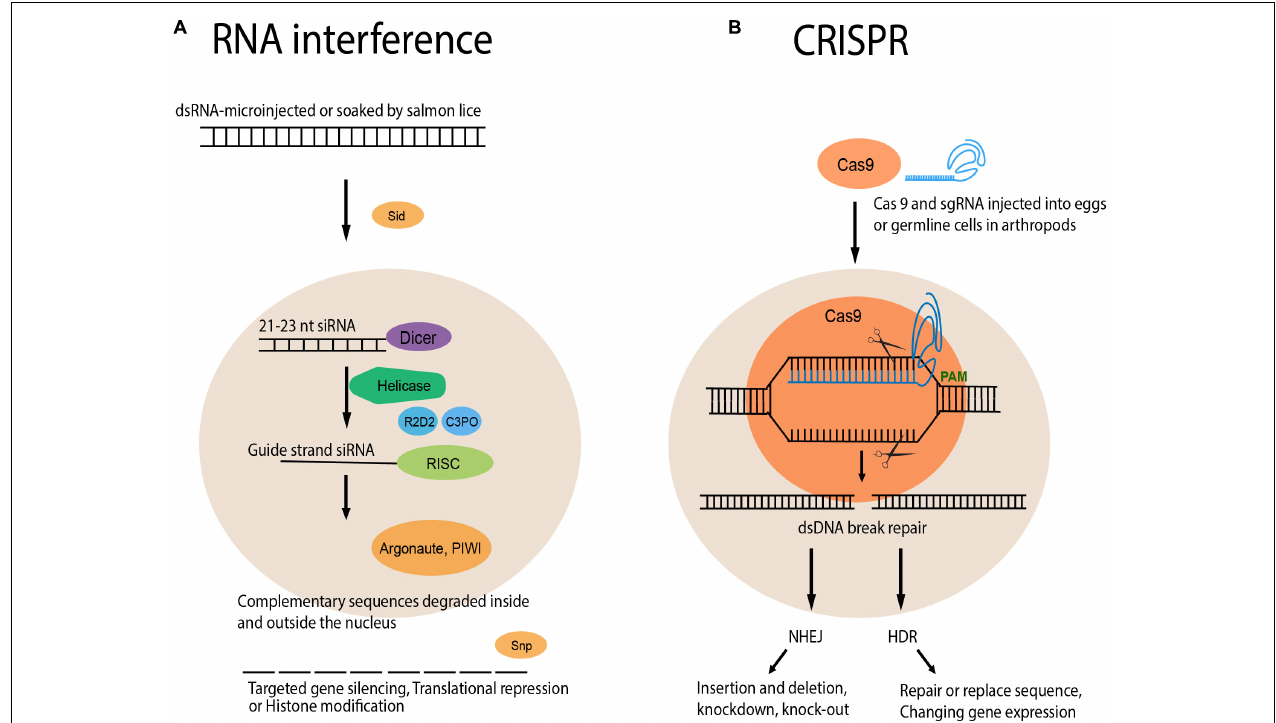
FIGURE 2 | Schematic representation of RNA interference and CRISPR/Cas9 technology. Two methods to target the activity of specific genes in the organism that are valuable for the functional study of genes and genetic elements. (A) RNA interference is a reverse genetics approach to study genes by knocking them down and then evaluating the effects. RNAi can be achieved in salmon lice by microinjecting dsRNA into pre-adult/adult lice or by immersing nauplii in dsRNA solution. dsRNA is incorporated in the cell with Sid, cleaved by Dicer into 21 nt small interfering RNA (siRNA), loaded into RNA-induced silencing complex (RISC) by R2D2 and C3PO. Argonaute and PIWI endonucleases degrade complementary RNA inside the nucleus, whereas Snp exonucleases degrades RNA outside. (B) CRISPR/Cas9 has the precision to target and knock out a single gene or genes in a gene family. Although the CRISPR/Cas9 is yet available for salmon lice, Cas9 and single guide RNA (sgRNA) can be injected into the eggs or germline cells similar to other arthropods. sgRNA forms a complex with Cas9 endonuclease, producing a dsDNA break. The dsDNA break is repaired by Non-homologous end joining (NHEJ) or homology directed repair (HDR). As a consequence, genes would be knocked out, knocked down, upregulated, or silenced. Adapted from Perkin et al.